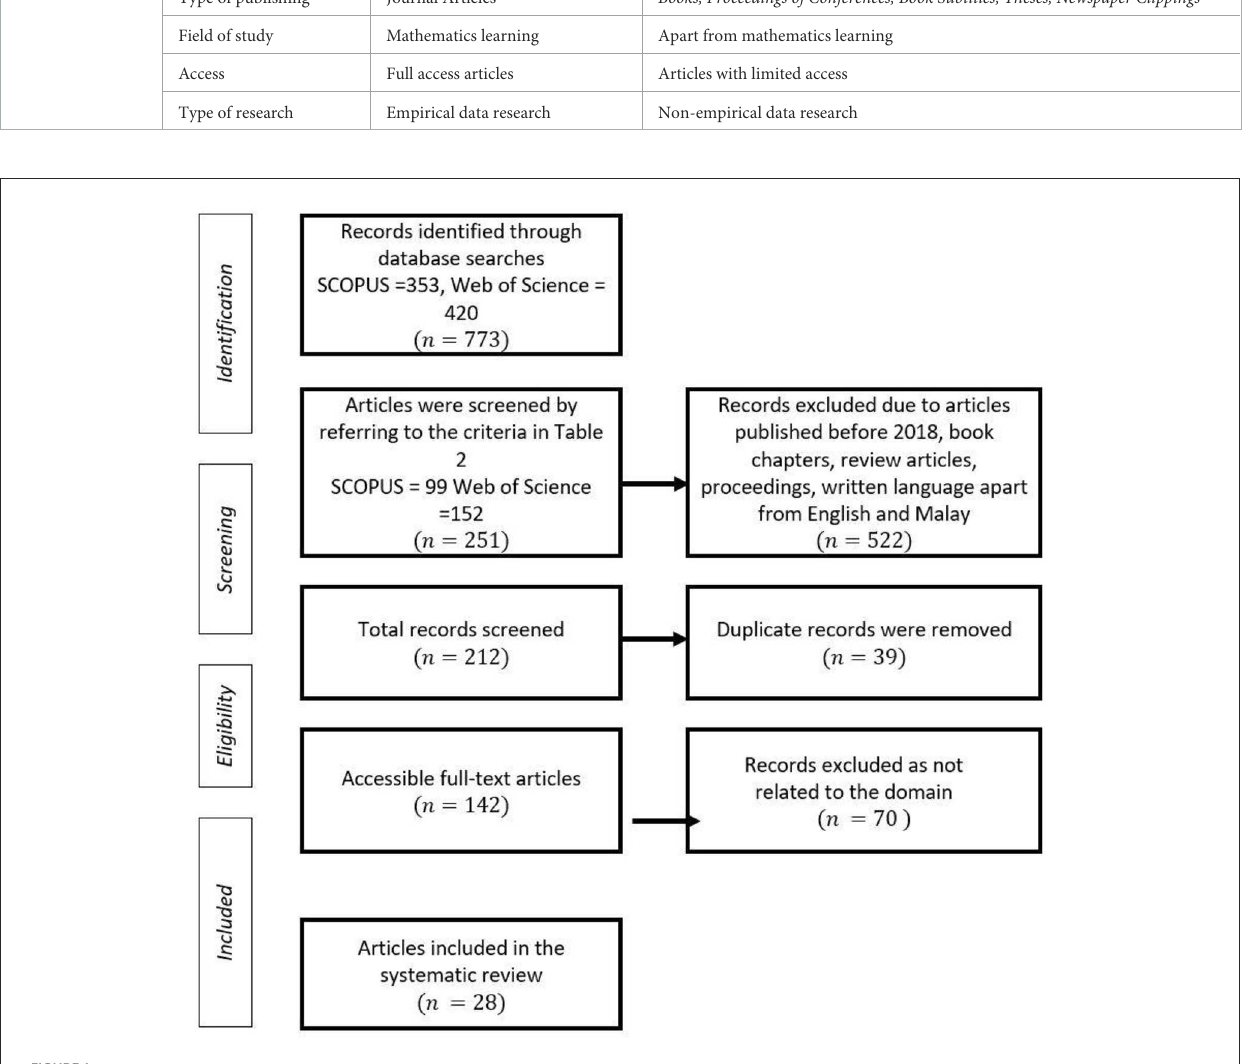
employed a mixed methods approach (Altanis et al., 2018; Ke, 2019; Yeh et al., 2019; Moon and Ke, 2020; Juric et al., 2021; Rocha and Dondio, 2021). Only two studies (7%) used a qualitative approach (Deng et al., 2020; Alkhede and Holmqvist,